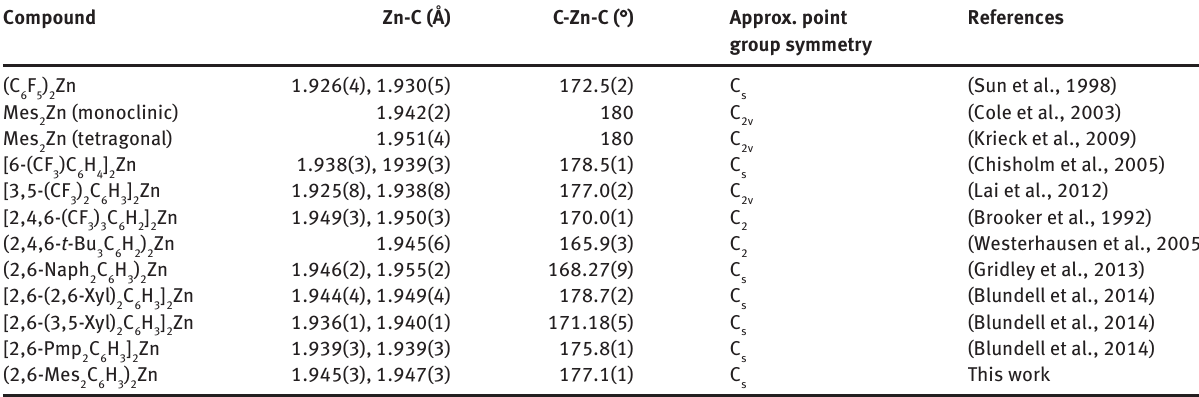
Table 1 Selected geometrical parameters of monomeric diarylzinc